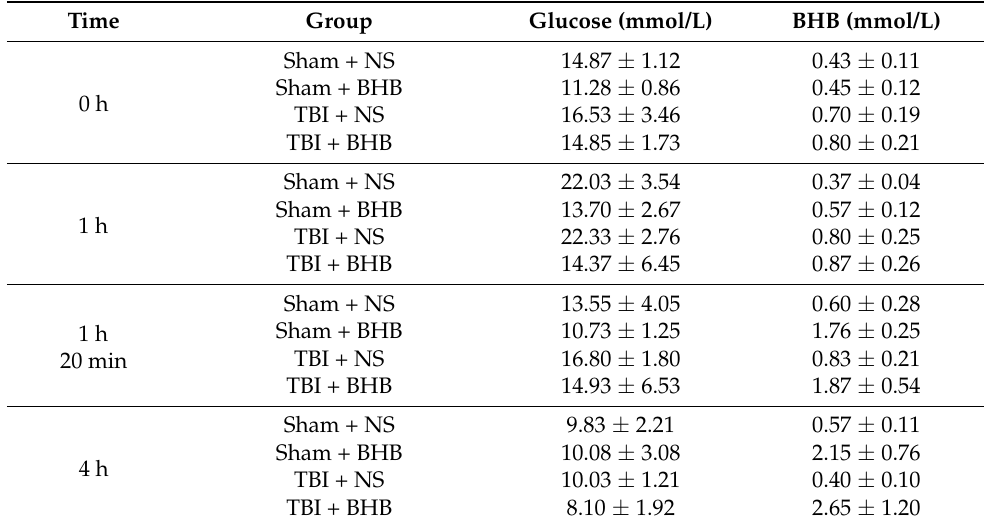
Table 1. Blood levels of glucose and β -hydroxybutyrate (BHB). Time